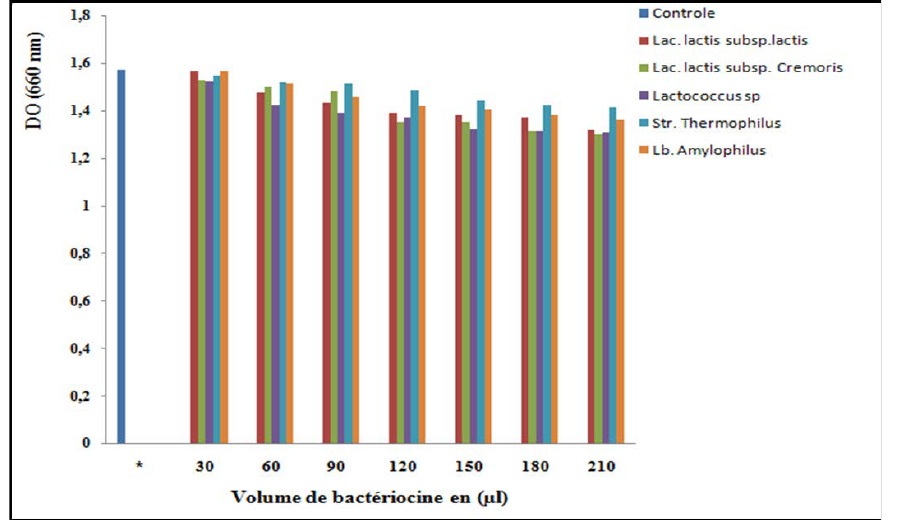
Fig. 5. Optical density of Staphylococcus aureus after treatment with bacteriocins produced by lactic acid